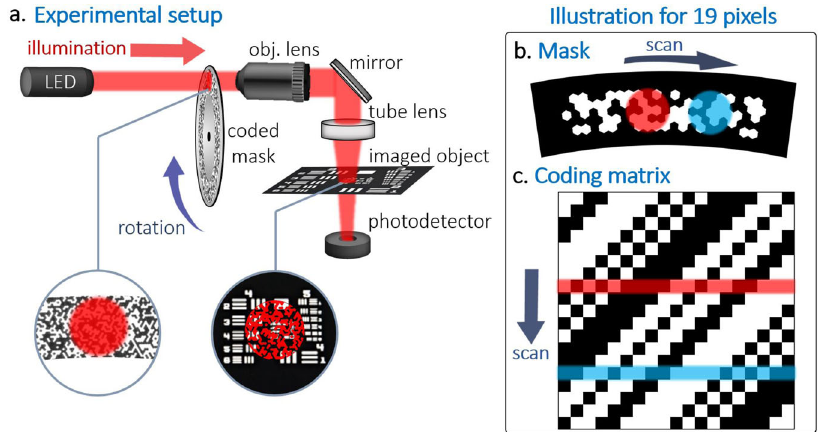
Fig. 1 Illustration of the rapid-SPI method. a Conceptual design of the imaging system with the rotating spatially coding mask. b Example of a 19th order cyclic mask changed by an element size shift of the mask the colors represent two different base functions. c Compatible 19 × 19